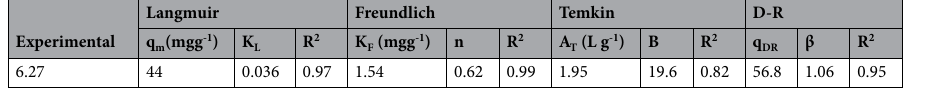
Table 9. Langmuir, Freundlich, Temkin and D-R linear isotherm parameters on PVA/CMC/TUR films.